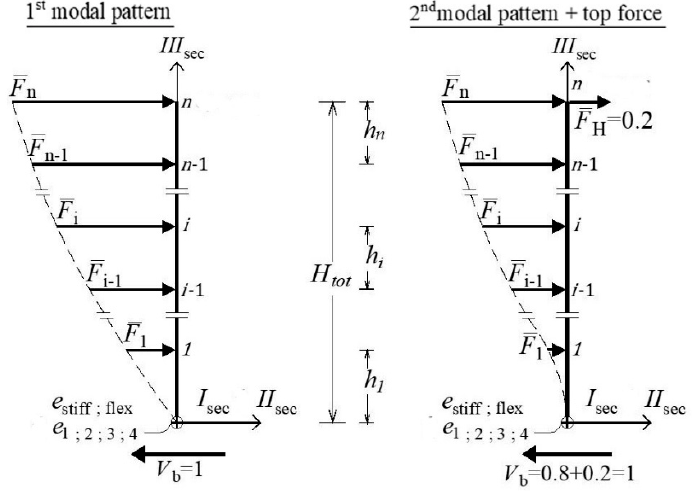
Figure 5. Vertical loading principal planes defined by the inelastic dynamic or design eccentricities along the I sec or II sec axes. Two patterns of floor lateral static forces are used in the proposed pushover procedure: an uncoupled translational modal one for each direction I sec and II sec and a modal one with a reduced base shear but with an additional top force.